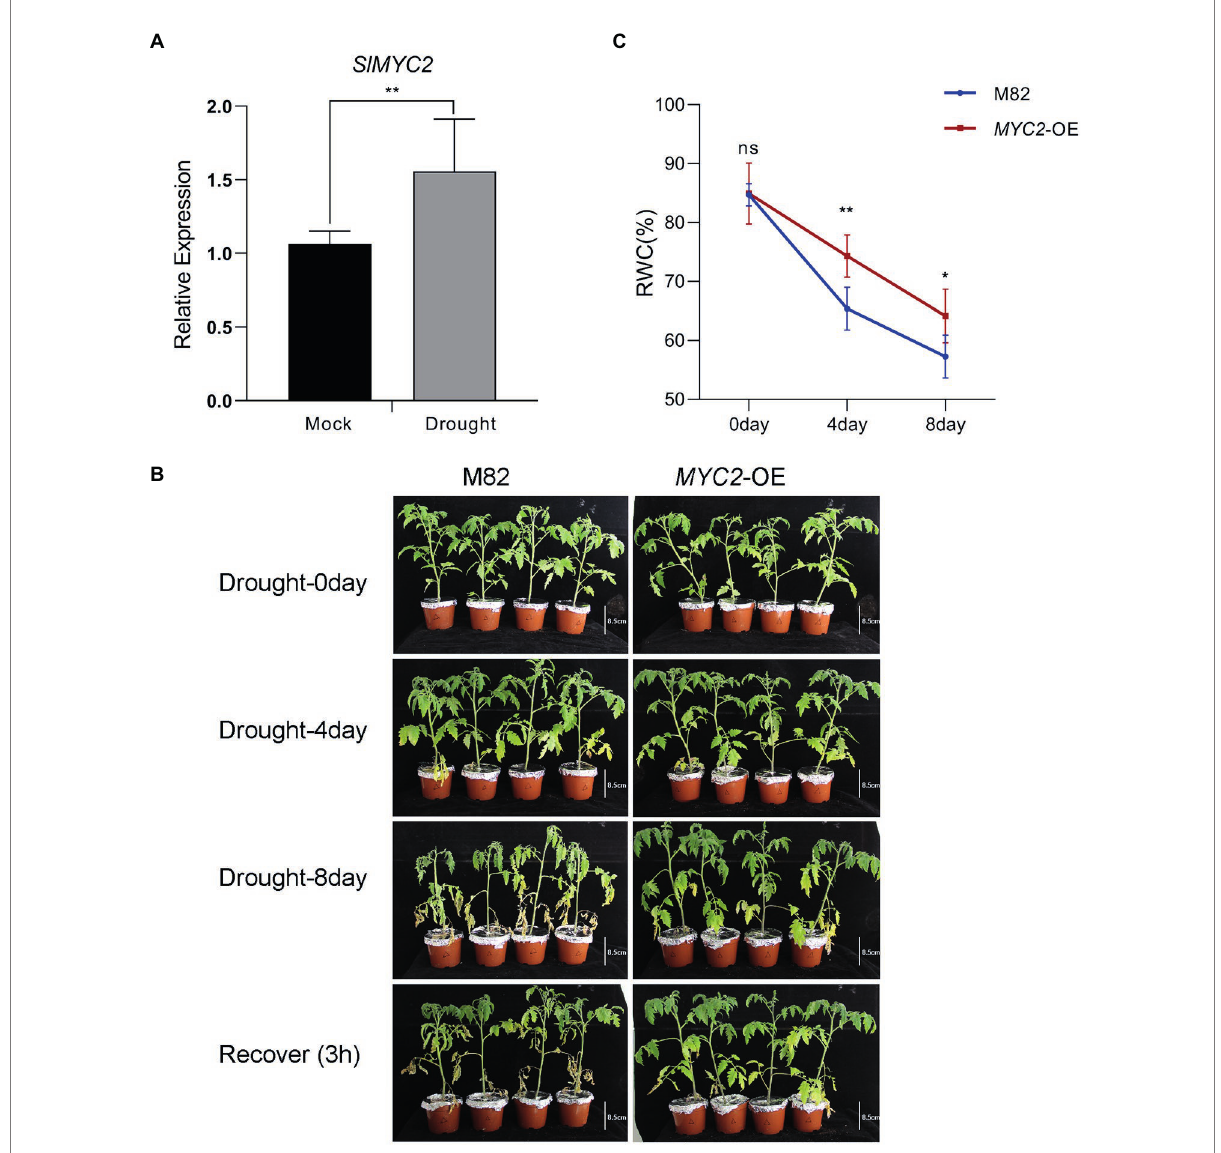
FIGURE 1 Increased tolerance of SlMYC2 -overexpressing plants to drought stress. (A) SlMYC2 expression patterns in tomato plant leaves under drought stress compared with mock treatments. (B) The phenotypes of MYC2 -OE and M82 plants under water loss conditions (bar = 8.5 cm). (C) RWC of leaves of MYC2 -OE and M82 plants during natural water loss. Asterisks represent significant differences (* p < 0.05 and ** p < 0.01) determined using Student’s t test and Tukey’s multiple comparisons